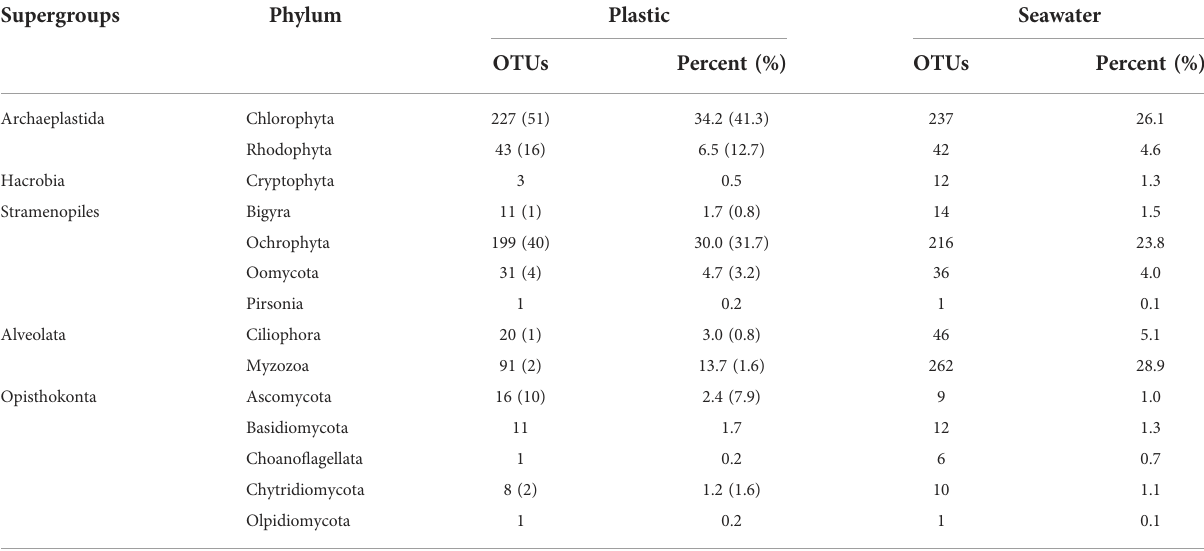
TABLE 1 The number of eukaryotic operational taxonomic units (OTUs) identi fi ed from plastic and seawater samples according to phylum.